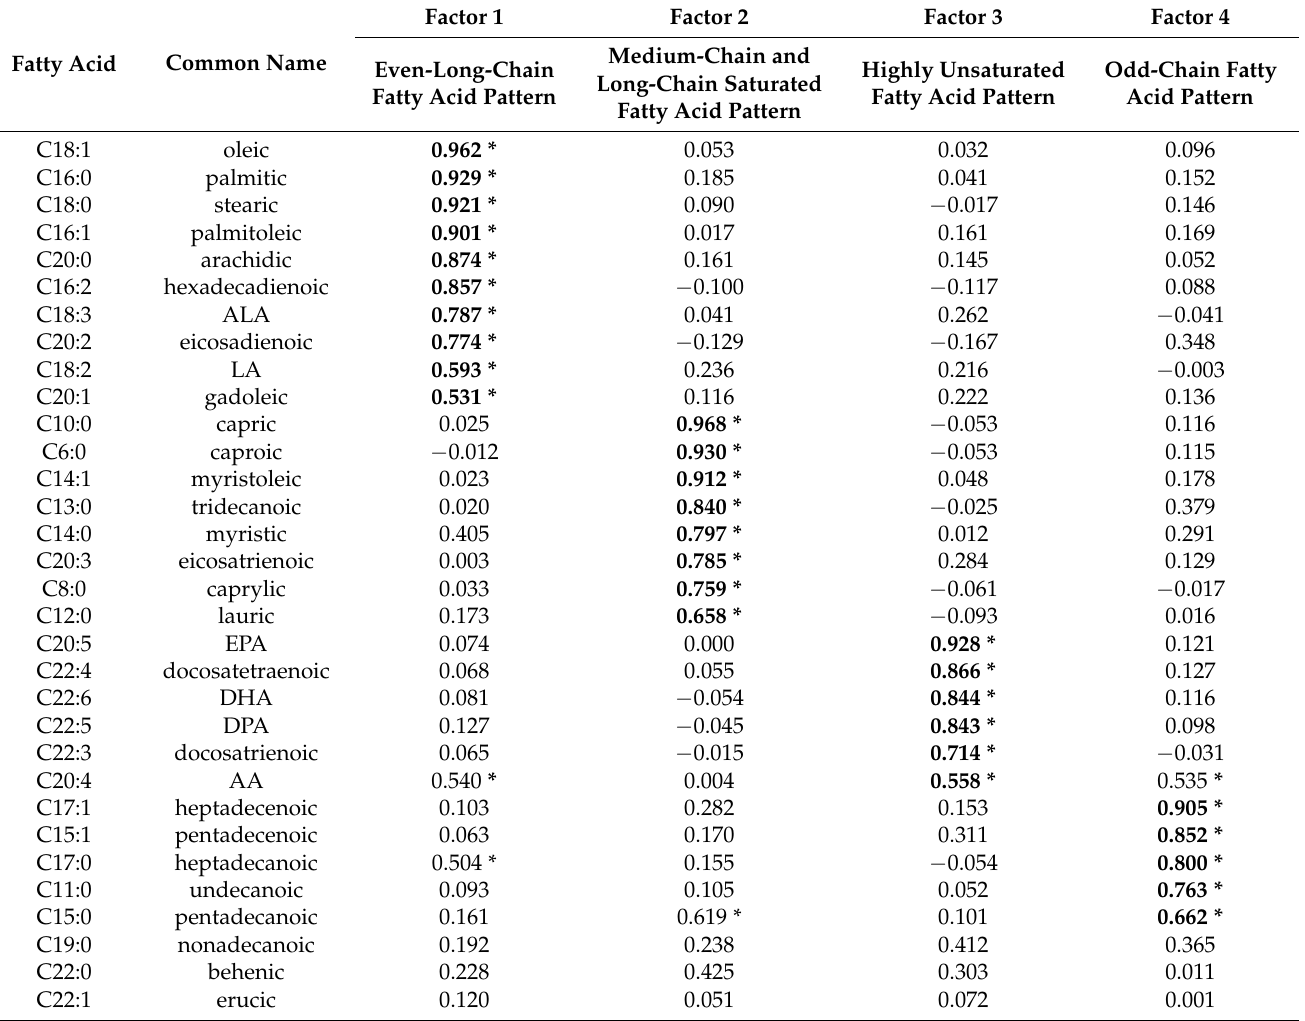
Table 2. Factor loadings of four dietary fatty acid patterns determined in 2806 control